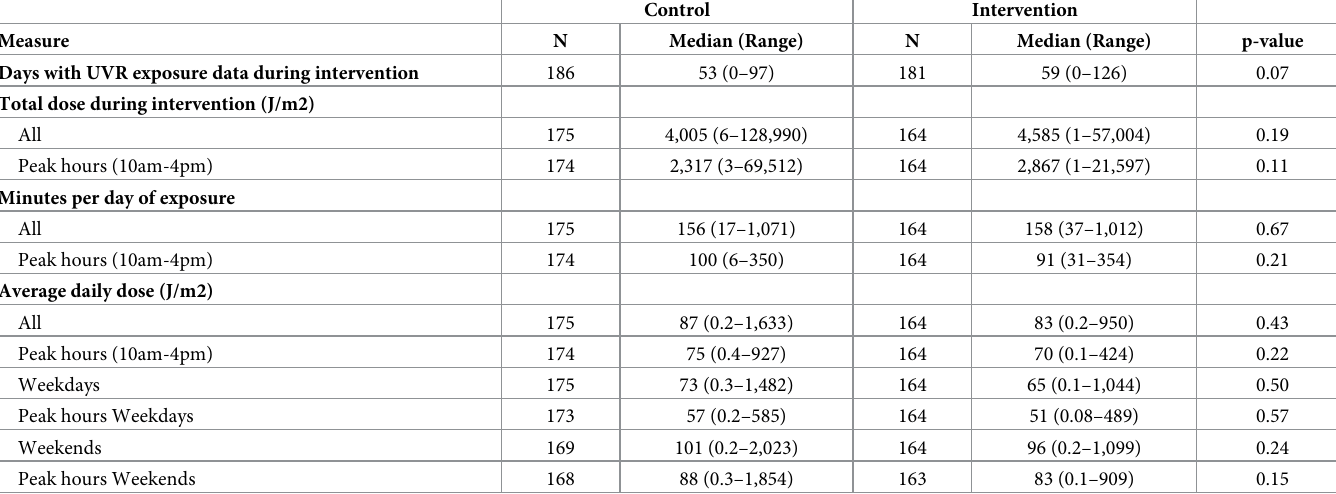
Table 5. Objective UVR exposure data during the intervention period by MELD randomization